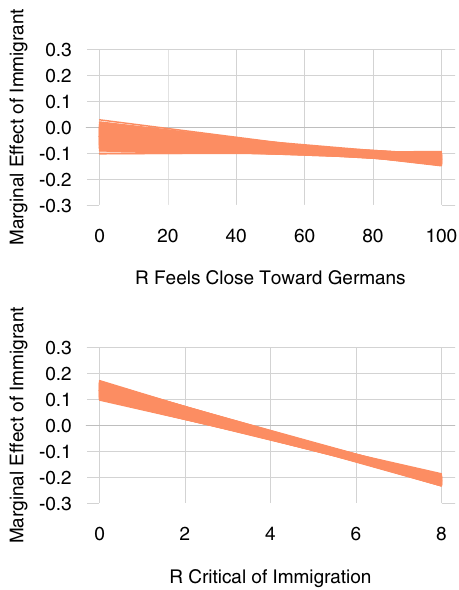
Fig. 2 Variation in the non-citizen immigrant penalty across respondents (marginal effects and simulated 95% con fi dence intervals). Pooled survey waves 1 –